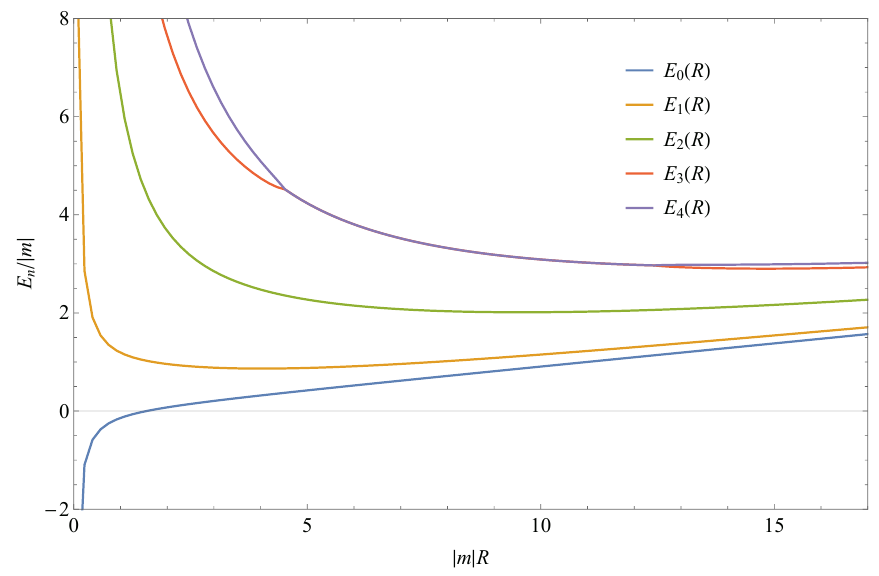
Figure 4 . 5 lowest energy levels at ξ 2 = − 0 . 035846 , this value is very close to the critical point − ξ 2 , where the theory is 0